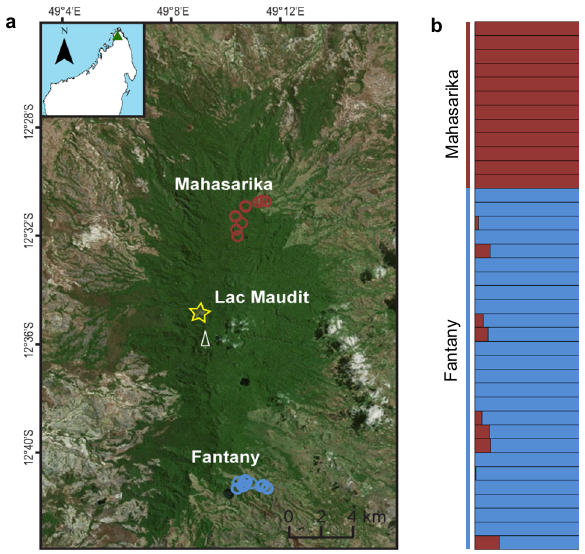
Fig. 1 Study area, sampling strategy, and population genetic structure. a Location of the study area in Montagne d ’ Ambre, in northern Madagascar showing the northern (1073 m asl) and southern site (848 m asl) for mouse lemur sampling (red and blue circles) and the study site for lacustrine sediment coring at 1250 m asl (star). All three sites were within 18 km of each other. The white triangle represents the mountaintop. The distribution area was drawn based on resources available in the public domain Microsoft Bing Virtual Earth . Individual coordinates can be found in Supplementary Table S2. b Assignment of 38 individuals to two genetic clusters ( K = 2) using genotype likelihoods. Each individual is represented by a single horizontal bar and each color represents a distinct genetic cluster. Samples are sorted by sampling site. The animals sampled in the northern and southern site were assigned to two distinct genetic clusters with low levels of admixture between the two